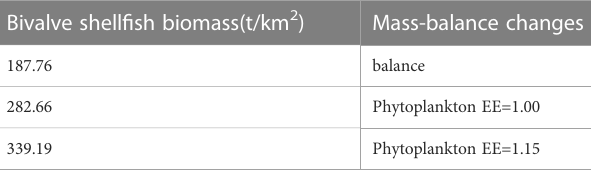
TABLE 3 Variation of other parameters in estimating the ecological carrying capacity of bivalve shell fi sh using the Ecoapth model. Bivalve shell fi sh biomass(t/km 2